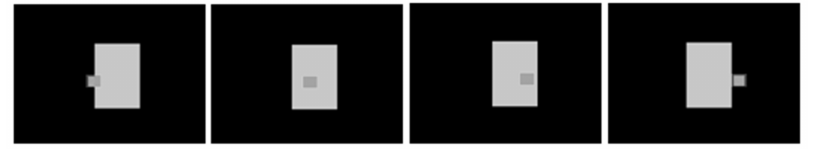
Figure 12. Result of memory tracking using α - β - γ filter in test imagery sequences. Dotted square is the prediction of target’s